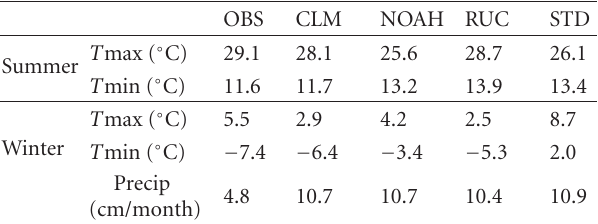
Table 2: Domain-wide averaged observations and simulations for precipitation and surface air temperature as shown in Figure